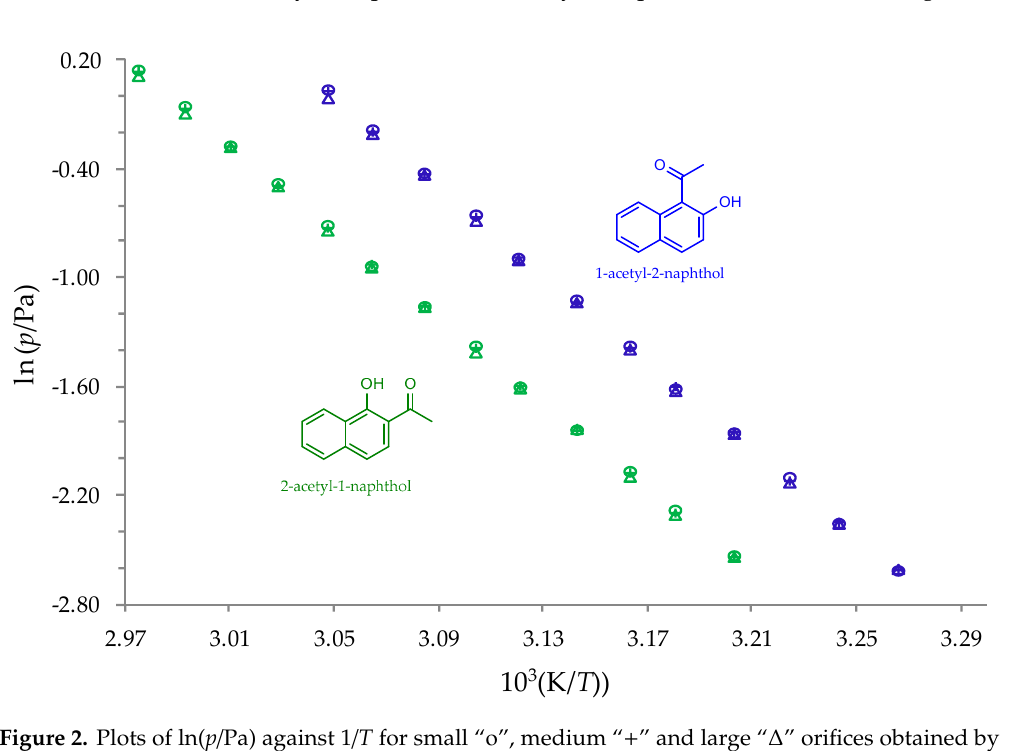
Figure 2. Plots of ln( p / Pa) against 1 / T for small “o”, medium “ + ” and large “ ∆ ” orifices obtained by Figure 2 . Plots of ln( p /Pa) against 1/ T for small " o ʺ , medium “ + ” and large “ ∆ ”orifices obtained by the the mass-loss Knudsen e ff usion experiments for 1-acetyl-2-naphthol (marked with blue colcor) and mass-loss Knudsen effusion experiments for 1-acetyl-2-naphthol (marked with blue colcor) and 2- 2-acetyl-1-naphthol (marked with green acetyl-1-naphthol (marked with green color).